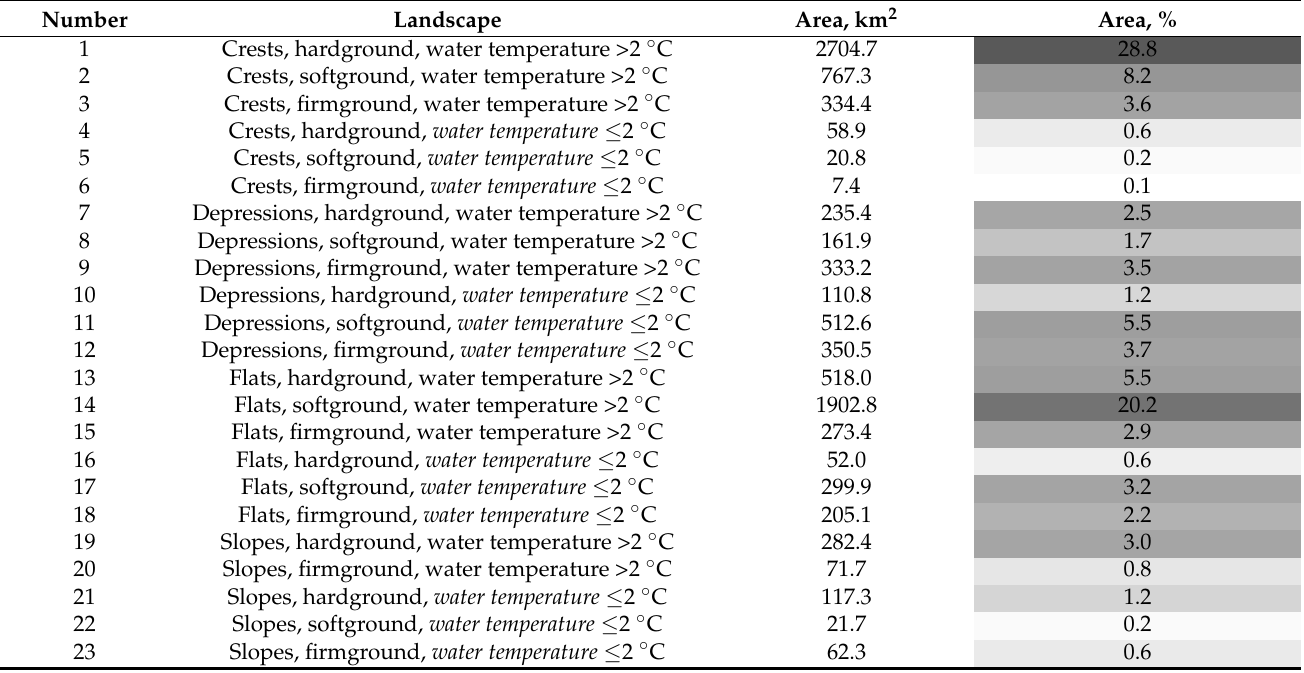
Table 3. Seabed landscapes resulted from the overlay of the BPI, substrate types, and water temperature. The percentage distribution of the landscapes in the area is marked by greyscale from high (dark grey) to low (white) values. Italian style highlights the landscapes with water temperature ≤ 2 ◦